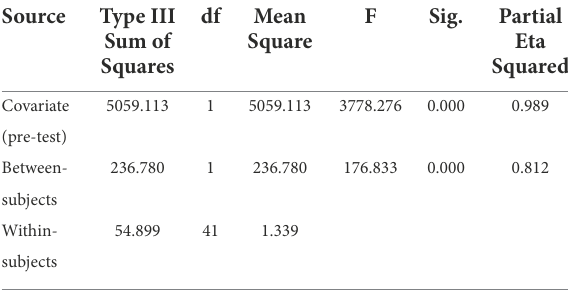
TABLE 4 ANCOVA results for listening